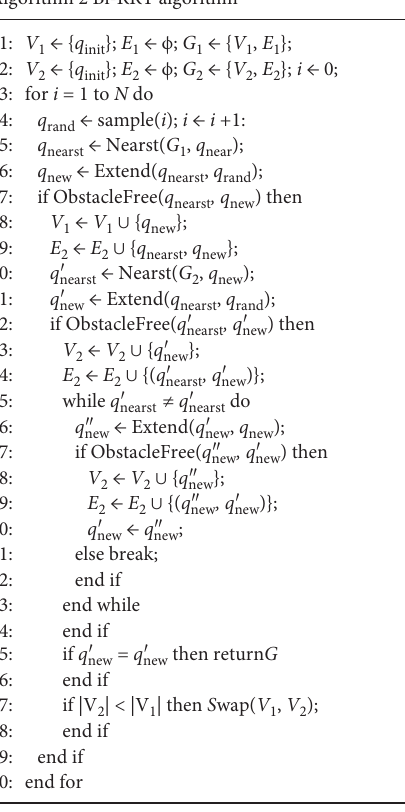
Algorithm 2 Bi-RRT algorithm